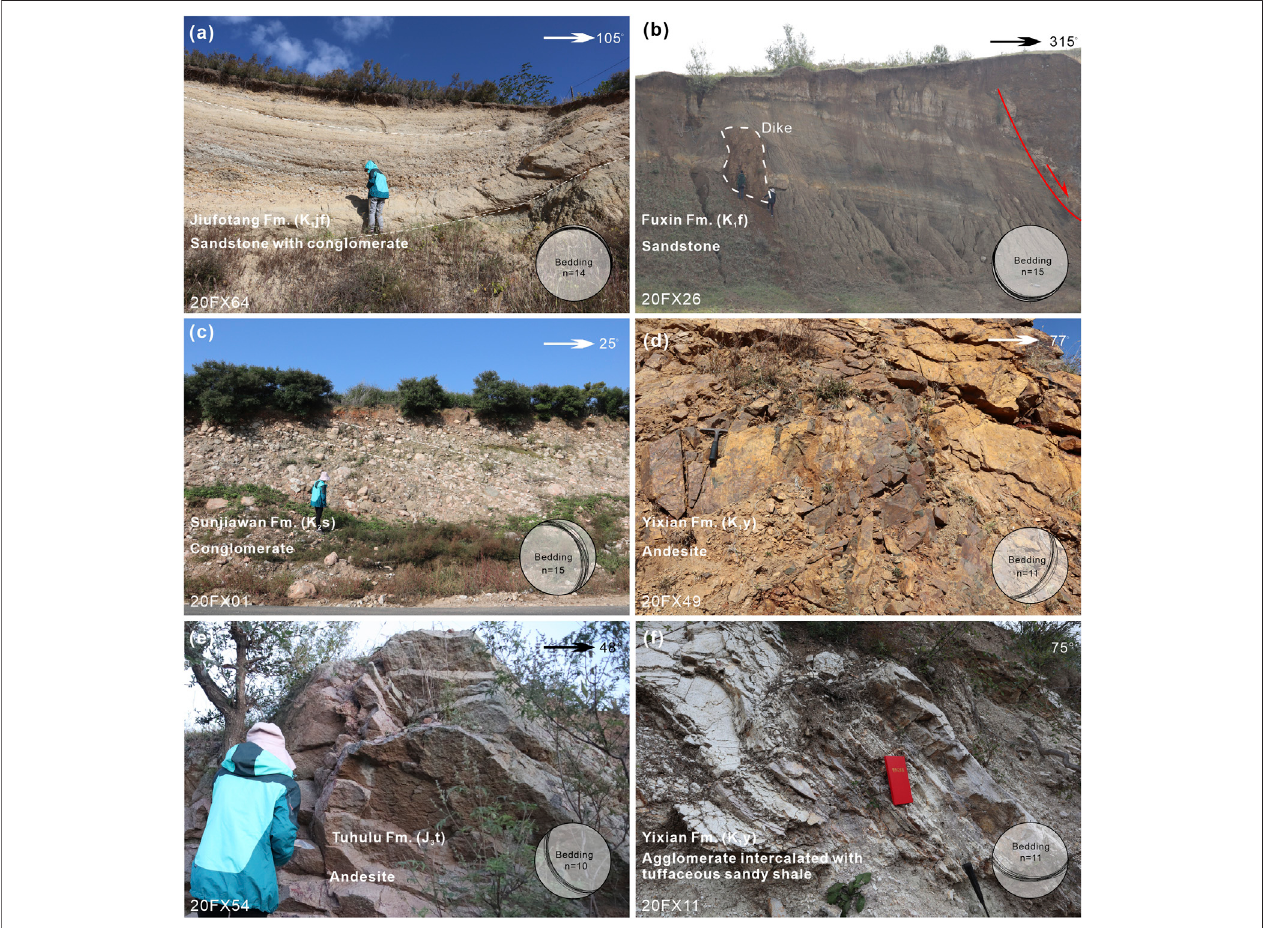
FIGURE 5 | Field photographs of the Fuxin Basin, showing the sedimentology and unconformities. (A) Conglomerates in the Shahai Formation. (B) Ma fi c dyke intruding sandstone of the Fuxin Formation that is cut by a normal fault. (C) Sandstone with conglomerate in the Jiufotang Formation. (D,E) Andesite in the Yixian and Tiaojishan formations. (F) Agglomerate interlayered with tuffaceous sandy shale in the Yixian Formation.